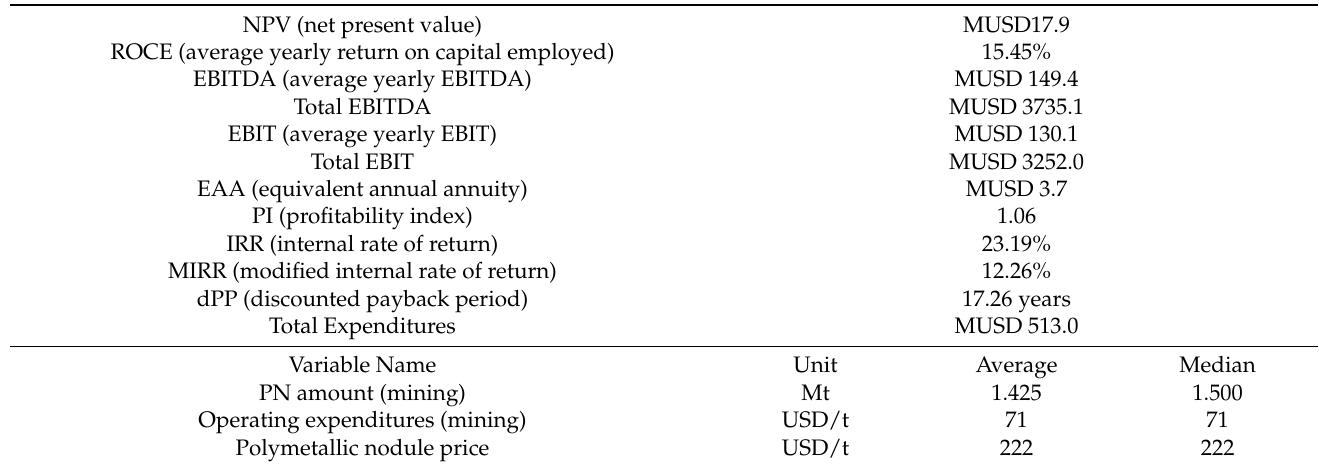
Figure 9. The results of the economic analysis of scenario 2, FCFF—free cash flow for the firm, dFCFF—discounted FCFF. Table 11. Economic indicators and variables, scenario